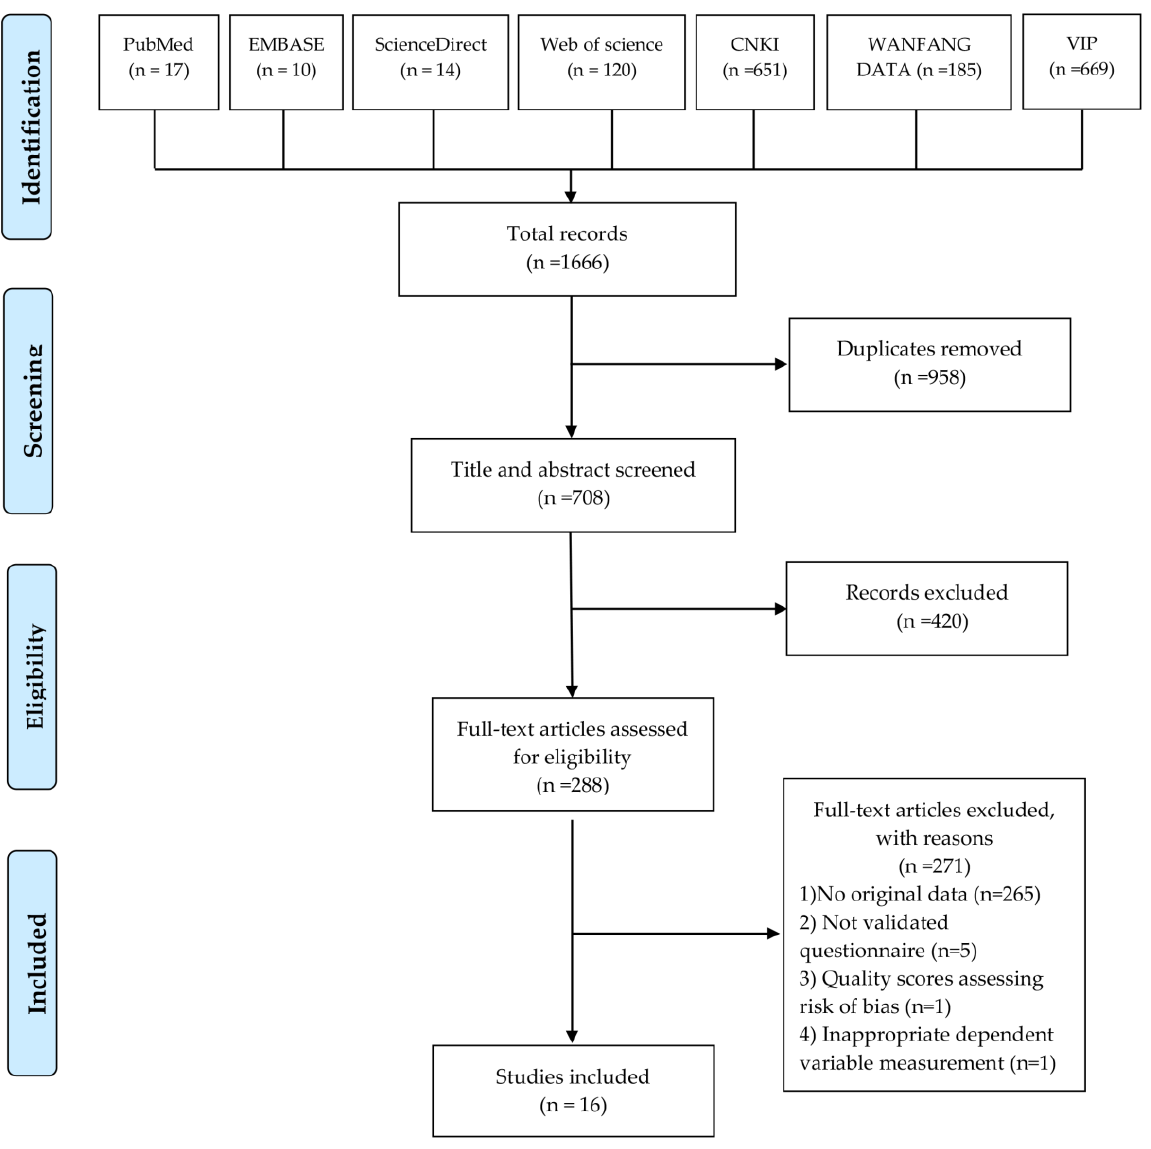
Figure 1. Flow diagram of study selection process.